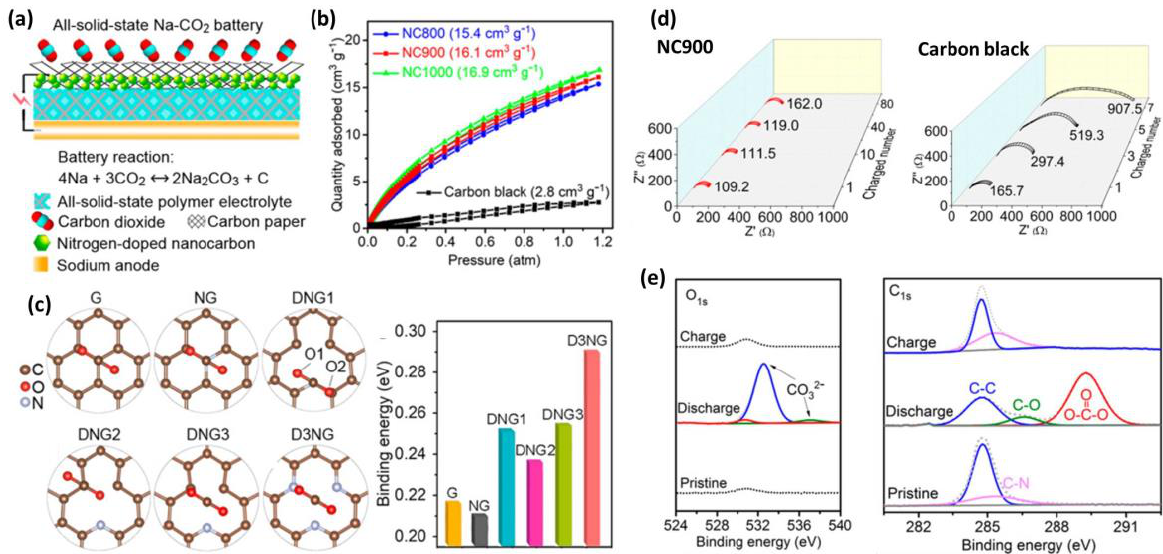
Figure 3. ( a ) All-solid-state Na-CO 2 battery configuration with N-doped carbon cathode; ( b ) Low-pressure CO 2 -adsorption isotherms for N-doped nanocarbons and carbon black at 273 K; ( c ) DFT calculations of undoped, graphitic N-doped, and pyridinic N-doped nanocarbon interacted with a CO 2 molecule and the calculated binding energies of one CO 2 molecule adsorbing on the undoped and doped nanocarbons; ( d ) Nyquist plots of Na-CO 2 batteries with NC900 cathodes and carbon black cathodes at different charged states; ( e ) XPS characterizations to confirm the reversible formation and decomposition of Na 2 CO 3 in discharged and charged progress. Reproduced with permission from [65]. Copyright 2021, American Chemical Society.